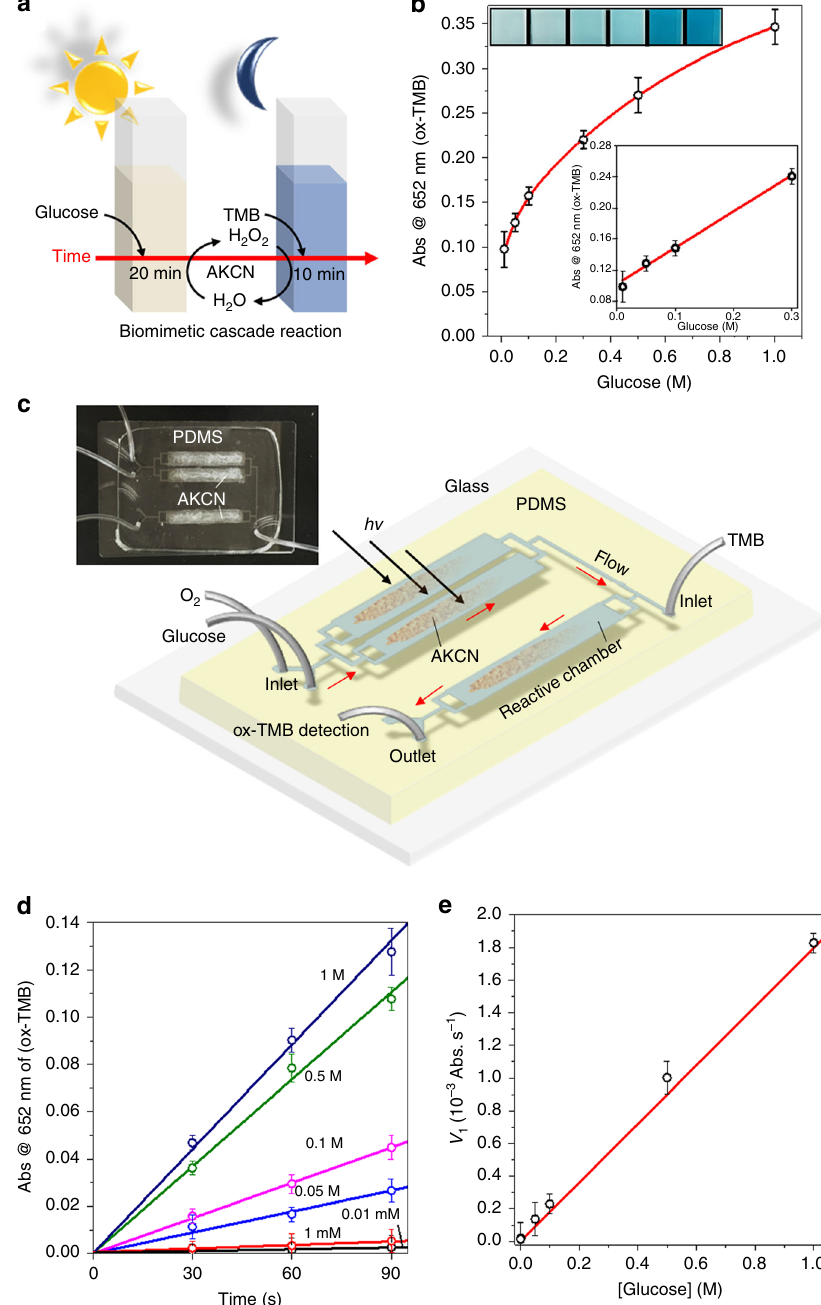
Fig. 7 Comparative enzymatic cascade reaction for glucose detection. a Scheme of the cascade reaction with continuous O 2 -purging in a batch mode. b The concentration-response curve with the linear calibration plots (inset) and colour change (inset) for glucose detection in batch reactor. The AKCN was employed as an oxidase (0.1M phosphate buffer, pH 7) and a peroxidase (0.1 M acetate buffer pH 4), sequentially in cascade reaction. c Scheme of the cascade reaction in a micro fl uidic device and actual device image (inset). d TMB oxidation by AKCN in the micro fl uidic channel (monitored as a function of time) for glucose detection in the concentration range of 0.01 mM – 1.0M. e The linear calibration for initial TMB oxidation rate ( v i ) vs. glucose concentration. The error bar represents the standard deviation from the repeated experiment after three times. Source data are provided as a Source Data fi